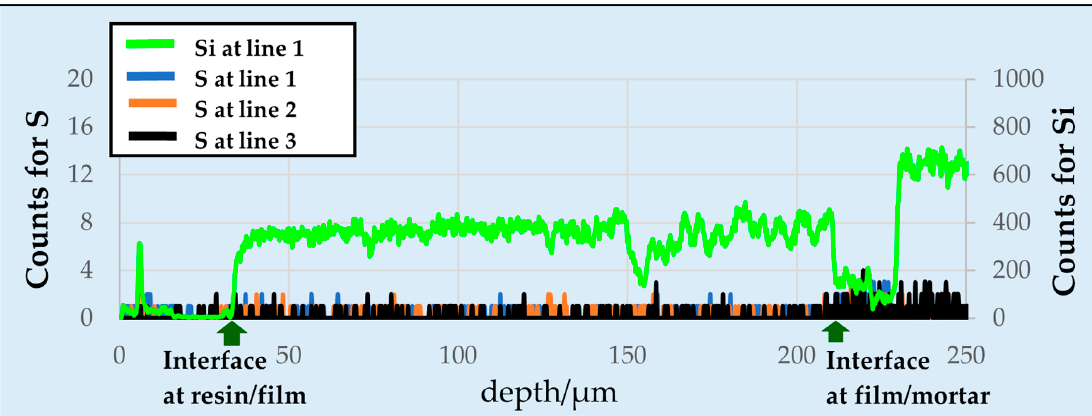
Figure 2. Line analysis of silicon (Si) and sulfur (S) by EPMA. The measured lines are shown in Figure 1.